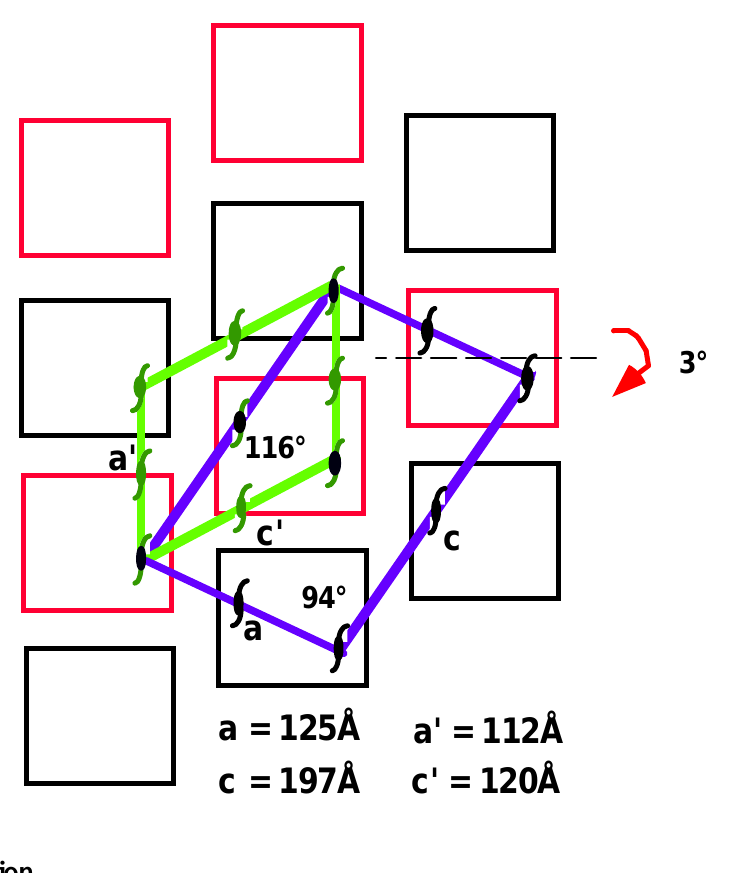
Figure 5. Schematic representation of the primary P2 lattice (the unit cell in blue) 1 containing two hexadecamers (black and red squares) in the asymmetric unit is shown. The postulated transition of the 2a crystal form (the blue cell) into the 2b crystal form, (the green cell), that proceeds through the hexadecamer rotation is marked by the arrow on the left. The corresponding symmetry elements are in black and dark green. The overlapping elements are in both colors. The relationships presented here are approximate.